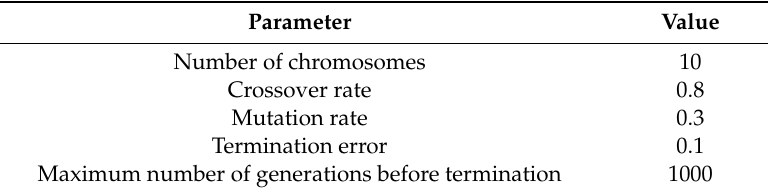
Figure 5. Number of artificial neural network (ANN) evaluations required by GA to obtain a certain maximum permissible error. Table 4. GA parameters used for